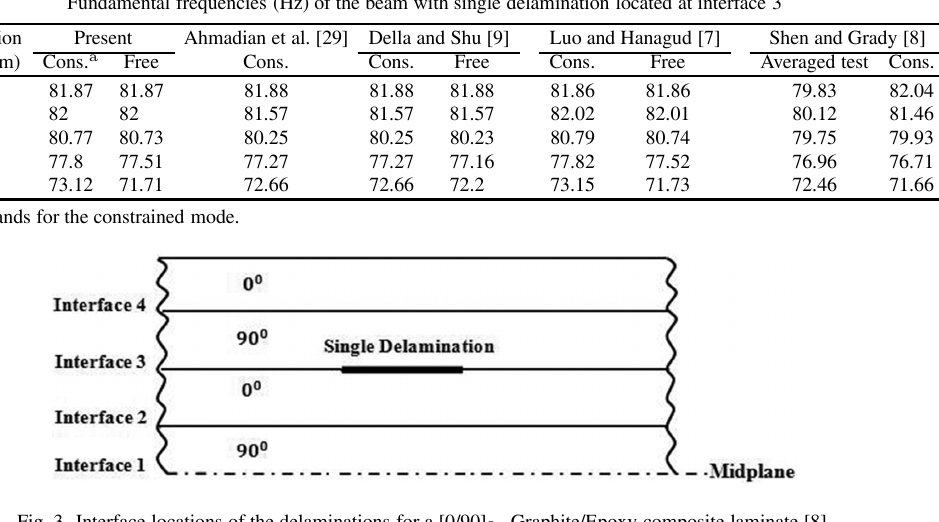
Fig. 3. Interface locations of the delaminations for a [0/90] 2 s Graphite/Epoxy composite laminate